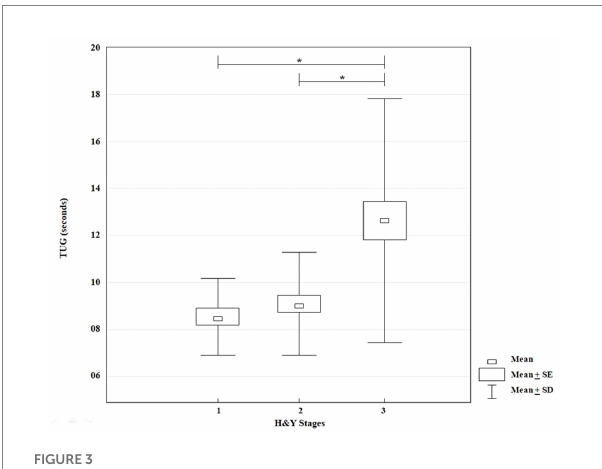
FIGURE 3 KW-ANOVA, demonstrating differences in the time to perform the Timed Up and Go between groups 1 and 3 and between groups 2 and 3.